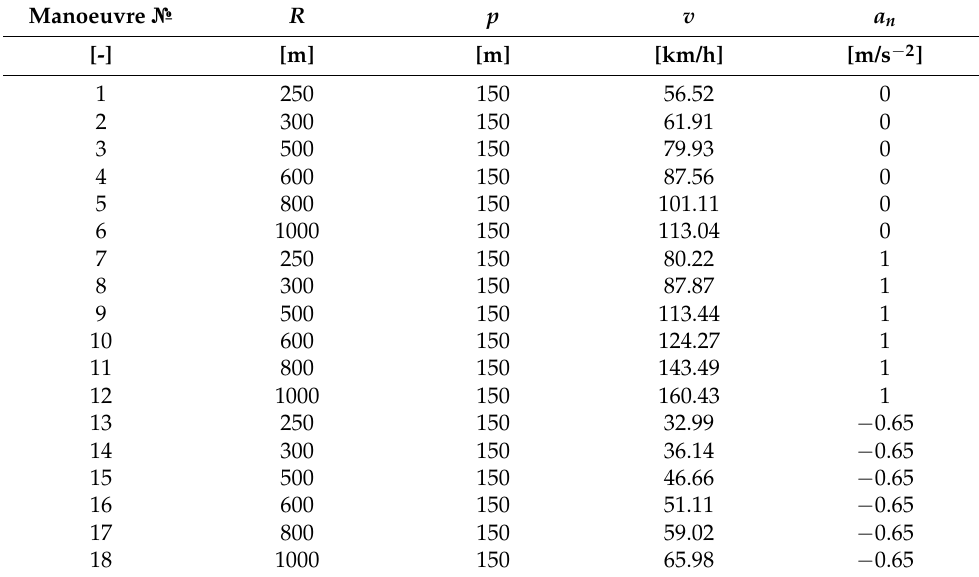
Table 4. Simulations